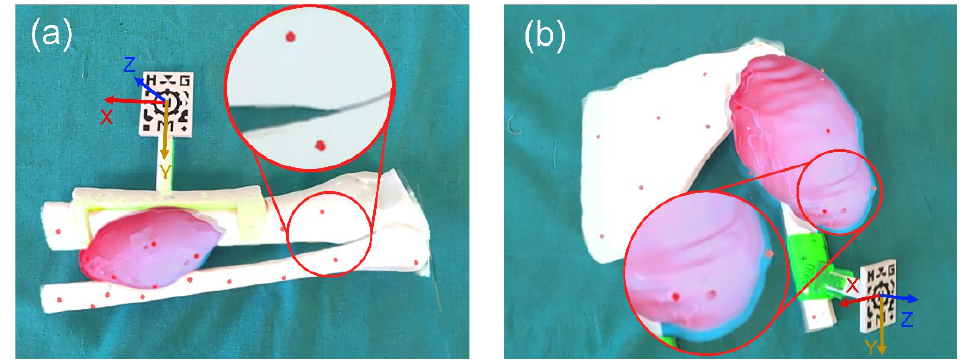
Figure 3. Control spheres projected over ( a ) phantom HL1HL2_Leg and ( b ) phantom HL2_Shoulder with Microsoft HoloLens 2.